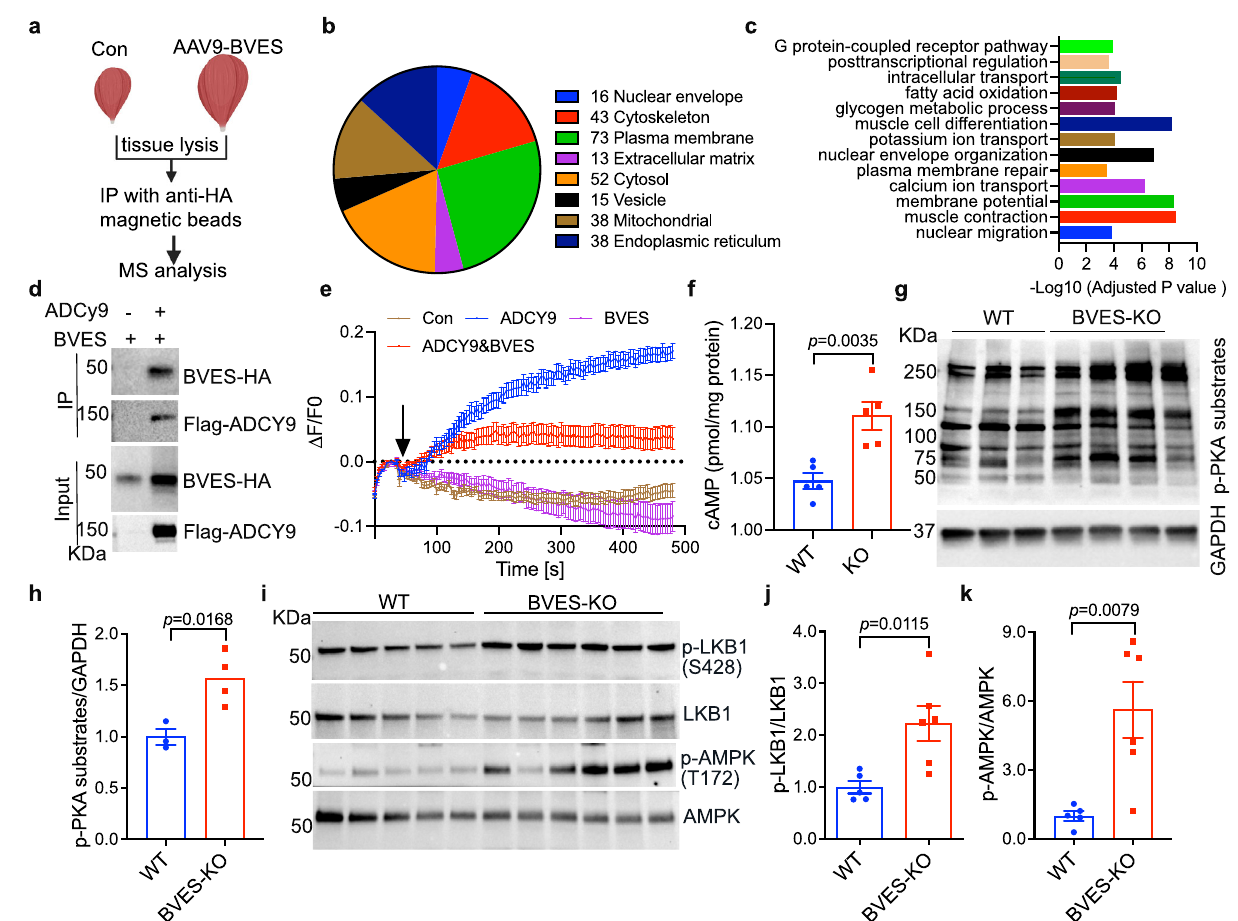
Fig. 4 | BVES interacts with ADCY9 and regulates cAMP/PKA signaling. All animalexperimentswereperformedinWTandBVES-KOmalemicewiththeC57BL/ 6N geneticbackground. a Diagram showing the IP-massspectrometryapproachto identify BVES-interacting proteins in mouse skeletal muscle (created with BioR- ender.com). b , c Gene ontology analysis of the cellular compartment ( b ) and bio- logical process ( c ) categorization of co-immunoprecipitated proteins with BVES- HA. d ADCY9 was co-immunoprecipitated with BVES-HA using the Flag antibody from the lysates of Cos-1 cells co-transfected with Flag-ADCY9 and BVES-HA (experiments were repeated twice). e IBMX (500 µ M)-induced cAMPr fl uorescence changes in ADCY3/6 doublemutant HEK293 cells with stable expression ofcAMPr,